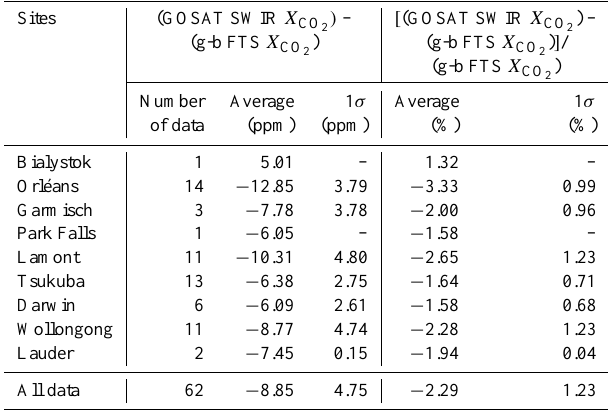
Fig. 4. Time series of GOSAT TANSO-FTS SWIR (blue triangles) and g-b FTS (pink squares) X CO and their scatter diagrams for (a) 2 Bialystok, (b) Orl´eans, (c) Garmisch, (d) Park Falls, (e) Lamont, (f) Tsukuba, (g) Darwin, (h) Wollongong, and (i)